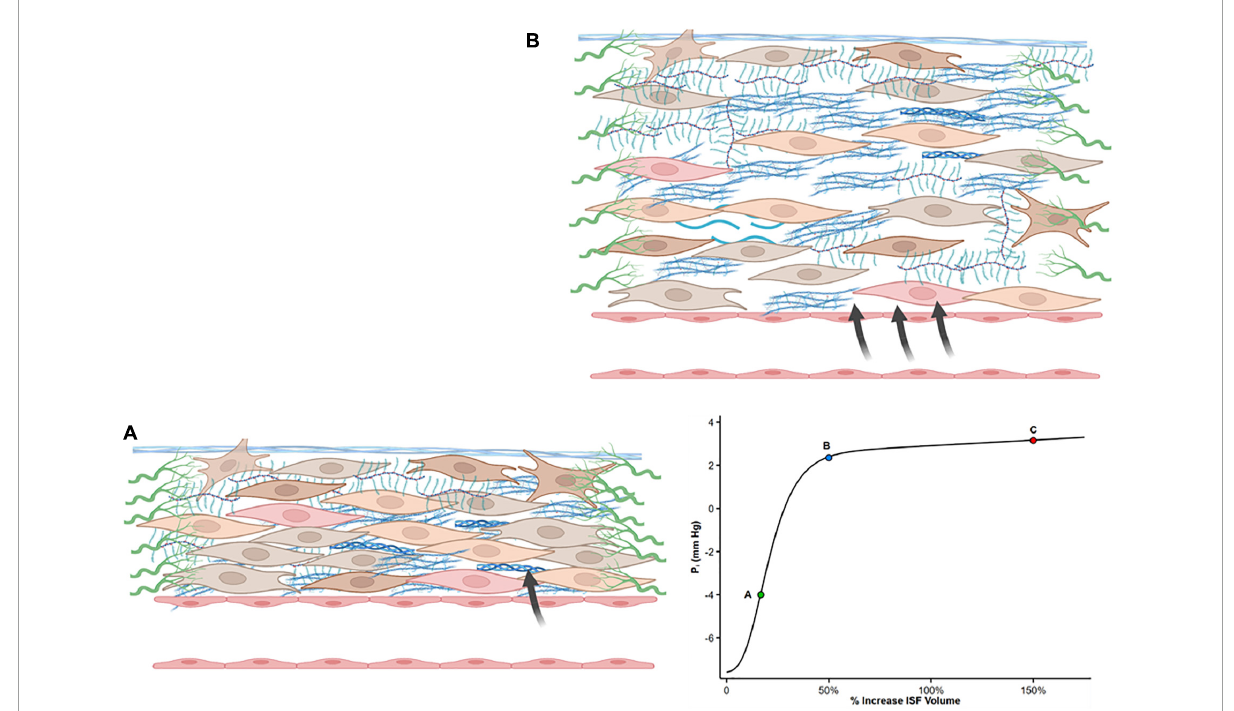
FIGURE1 Shape of the interstitial volume–pressure relationship. Zero represents euvolemia. At low interstitial volume, compliance is low, and an increase in volume causes pressure to rise steeply (from A to B ), opposing further filtration. This steep increase in pressure is produced by tensile forces applied by fibroblasts and extracellular matrix. With further interstitial fluid accumulation, typically interstitial volume 20–50% above euvolemia, interstitial compliance markedly increases as a result of structural changes, and large changes in volume result in a minimal increase in pressure (from Point B to C). Modified from references (50, 51, 55,